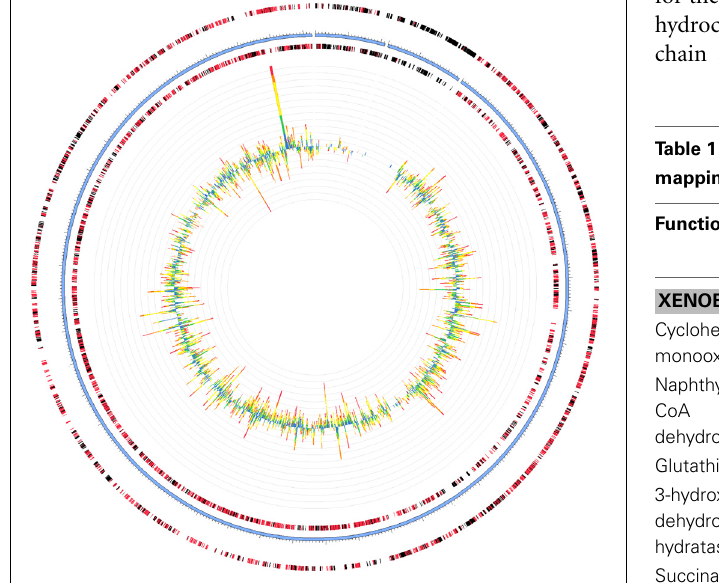
FIGURE 3 | Recruitment of June 3 metatranscriptome to Marinobacter aquaeolei strain VT8, the organism to which the largest number of contigs mapped for both metatranscriptomes. The genome is approximately 4.8Mb in size and the leading and lagging strands are represented by the outer most rings, separated by the blue ring, which indicates the position within the genome. Metatranscriptomic features are depicted as bar graphs inside the genome and their hit distribution is color-coded by e-value exponent as: blue, − 3 to − 5; green, − 5 to − 10; yellow, − 10 to − 20; orange, − 20 to − 30; red, less than − 30. Figure was generated using the MG-RAST recruitment plot tool.